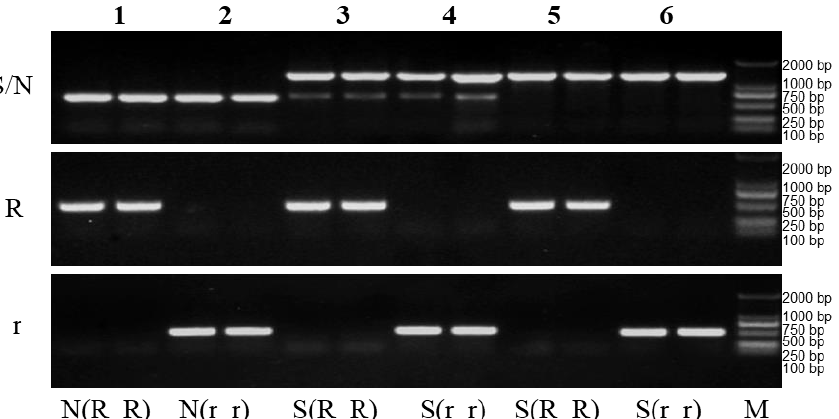
Figure 4. Identification of rapeseed germplasm with the CMS three-line molecular markers. N, fertile cytoplasm gene N; S, sterile cytoplasm gene S; R, fertility nuclear restorer gene; r, recessive nuclear sterile gene; M, DNA marker. The Arabic numbers (1 to 6) indicates different types of the three CMS lines: CMS sterile lines (samples 4 and 6), maintainers (sample 2) and restorers (samples 1, 3 and